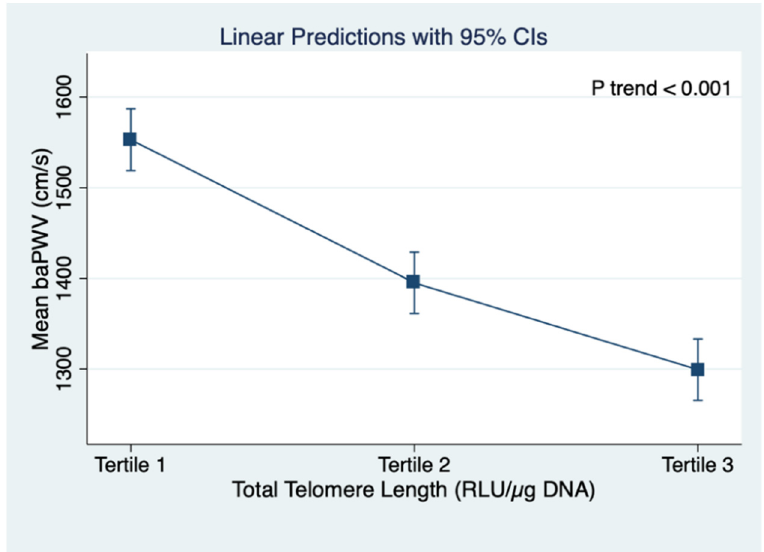
Figure 3. Linear regression predictions of mean baPWV and total telomere length across the tertiles of total telomere length, baPWV: brachial–ankle pulse wave velocity; CI: confidence intervals. Tertile 1: 103771.35~334193.49 RLU/ μ g DNA, Tertile 2: 334193.49~376734.07 RLU/ μ g DNA, and Tertile 3: 376734.07~596420.43 RLU/ μ g DNA).